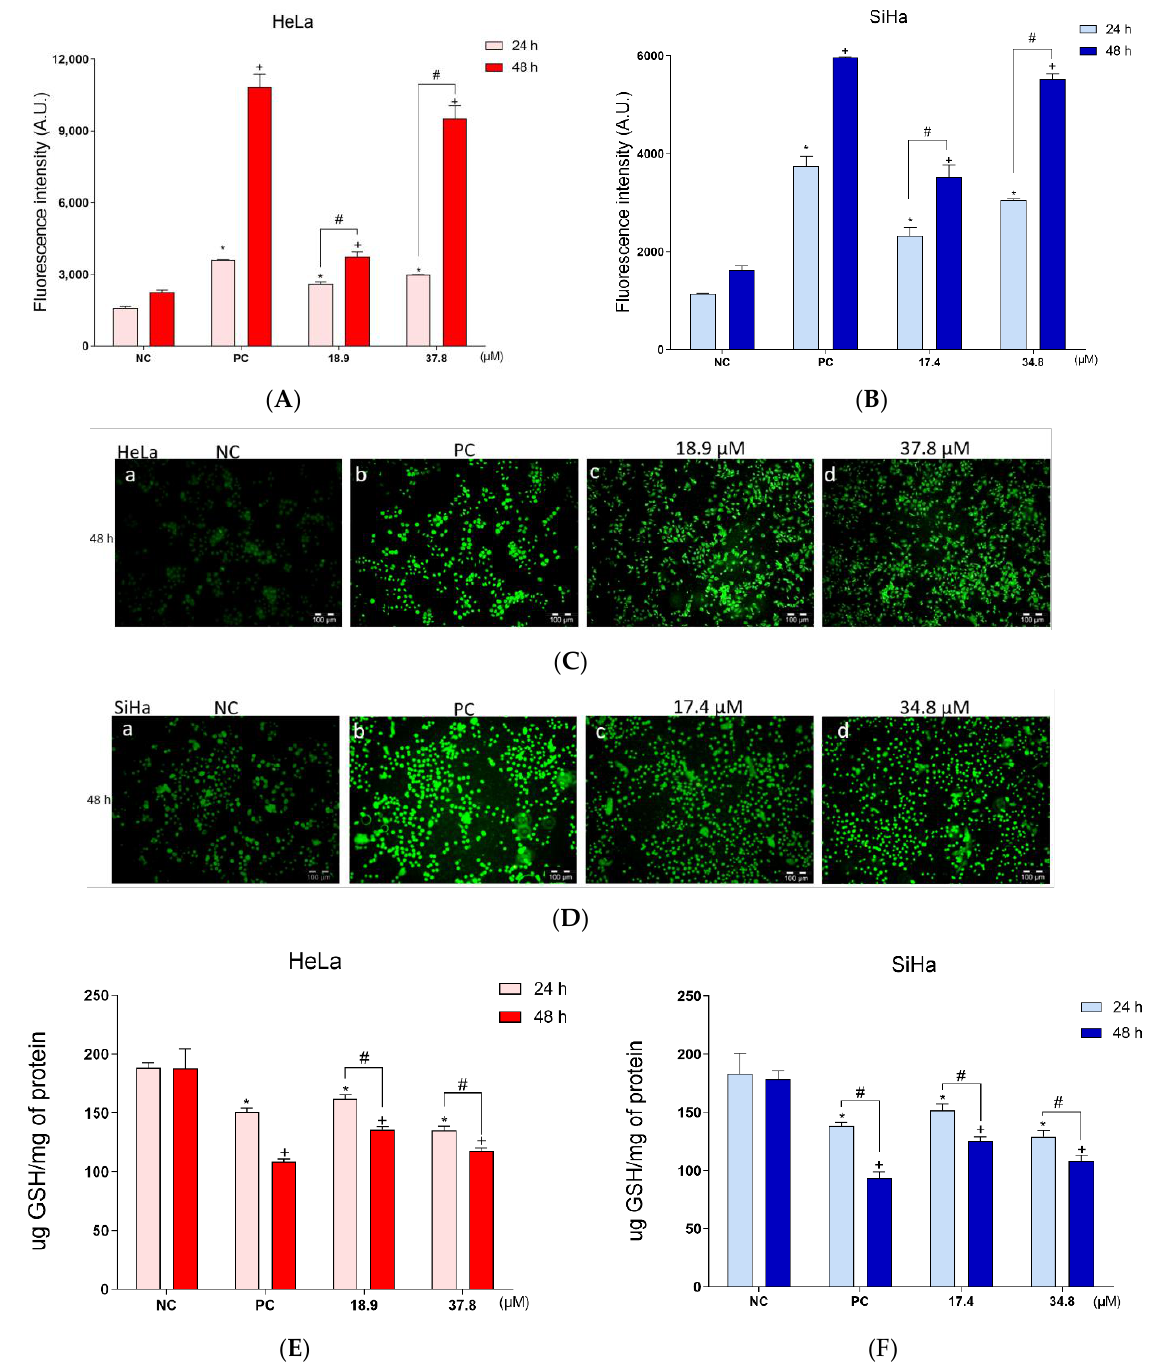
Figure 5. Assessment of oxidative stress. Determination of ROS by the dye H 2 DCFDA in HeLa ( A , C ) and SiHa ( B,D ). Assessment of GSH levels by OPA method in HeLa ( E ) and SiHa ( E ) cells. For both experiments, cells were treated with A3K2A3 (IC 50 or 2xIC 50 ) for 24 and 48 h. The PC was H 2 O 2 (200 μM). Fluorescence intensity was obtained by spectrofluorimetry. Data represent the mean ± SD of three independent experiments that were performed in triplicate. * p < 0.05 compared to 24 h NC, + p < 0.05 compared to 48 h NC, # p < 0.05 significant difference between 24 and 48 h incubation times (two-way ANOVA followed by Tukey ’ s post-test). In C and D, HeLa and SiHa were photographed using an Olympus ® BX51 fluorescence microscope coupled with a UC30 camera (magnification 10 ×; scale bar: 100 μm), after 48 h treatment.